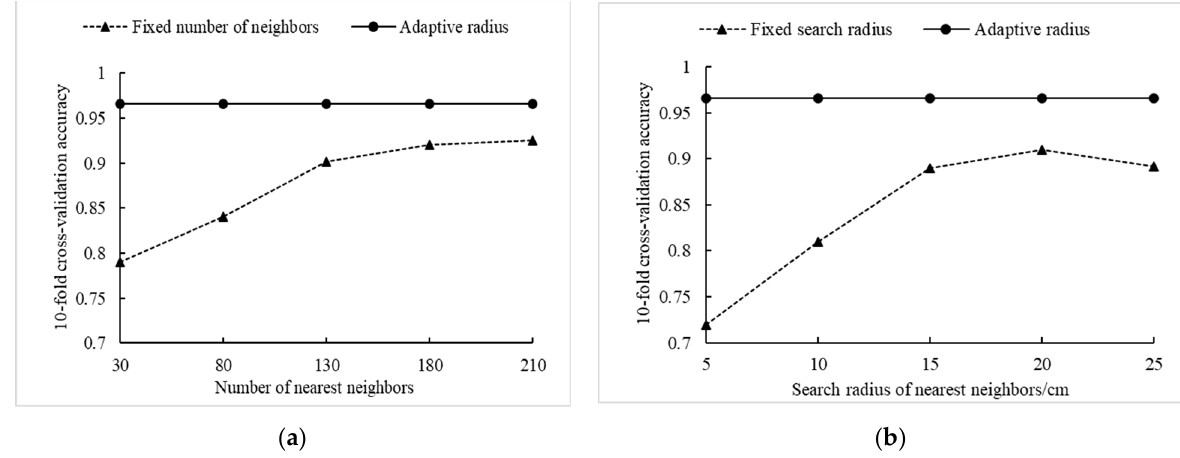
Figure 7. Comparison of training accuracy between adaptive radius search and traditional KNN search methods. ( a ) Fixed number of neighbors (Method I) and adaptive radius search (Method III), ( b ) Fixed search radius (Method II) and adaptive radius search (Method III).